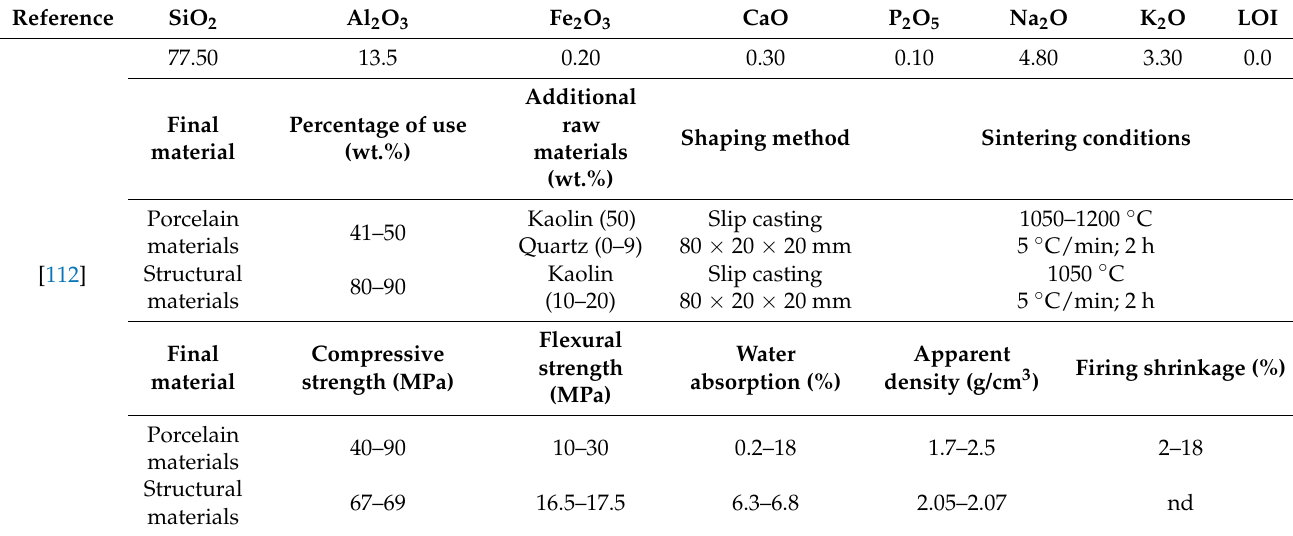
Table 11. Chemical composition (expressed wt.% oxide), processing parameters and technological properties of ceramic materials developed from lithium mining